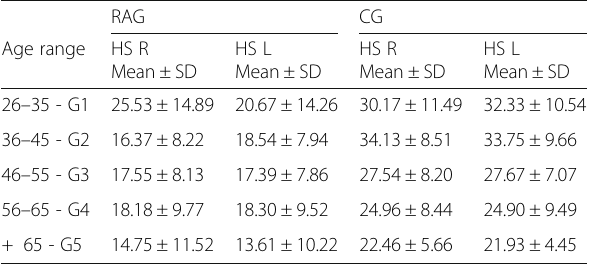
Table 5 Handgrip strength per age range in the rheumatoid arthritis group (RAG) and the control group (CG) RAG